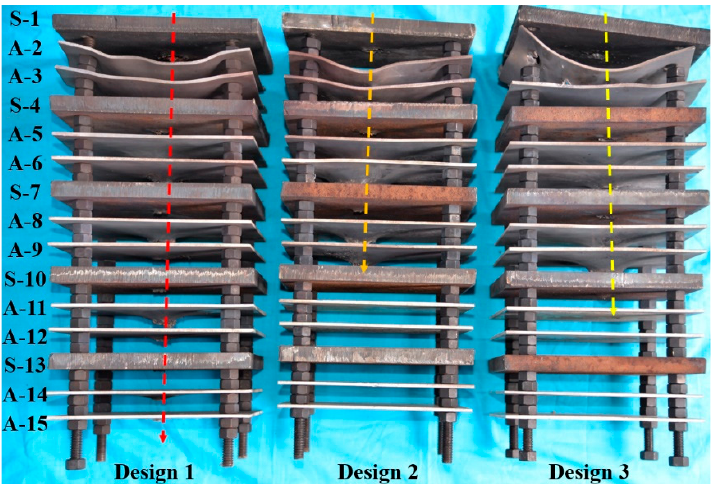
Figure 7. Damaged multilayer targets.